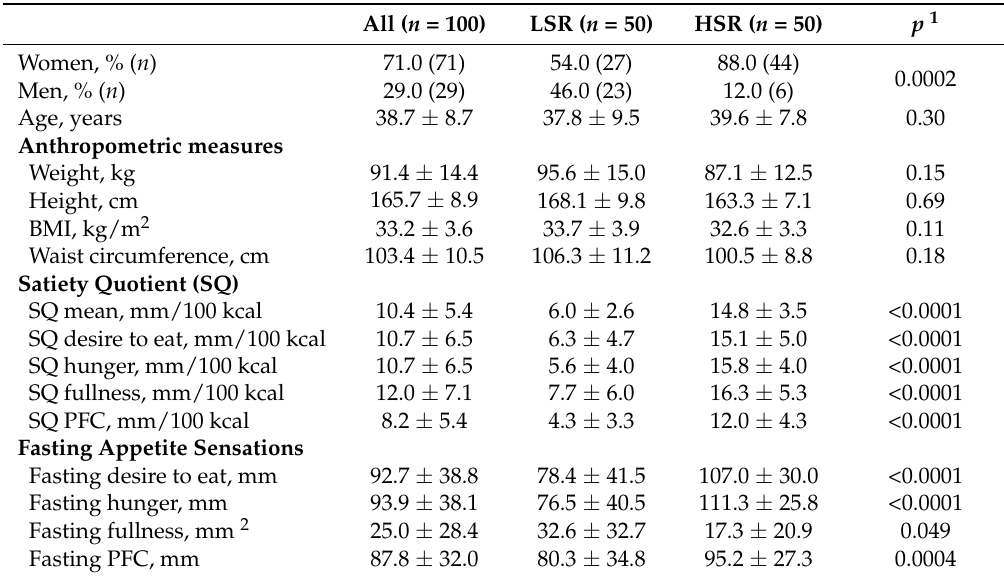
Table 2. Baseline participant